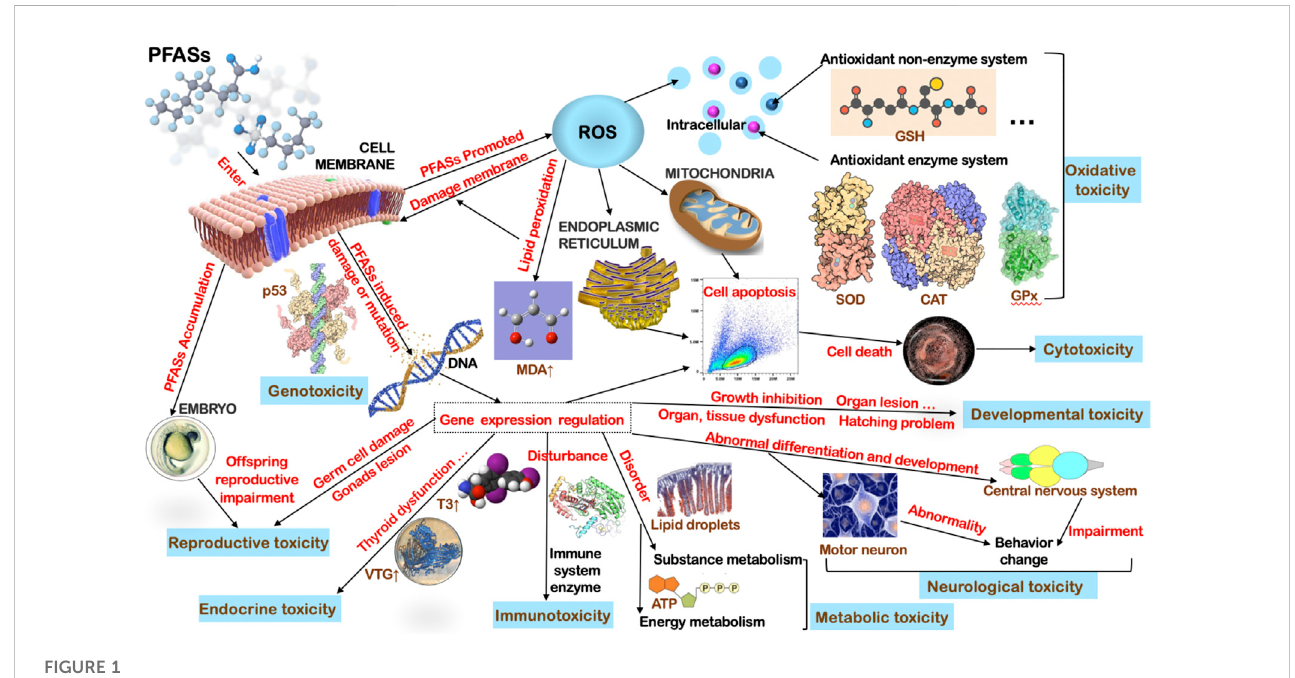
FIGURE 1 General toxicological mechanisms of PFASs on fi